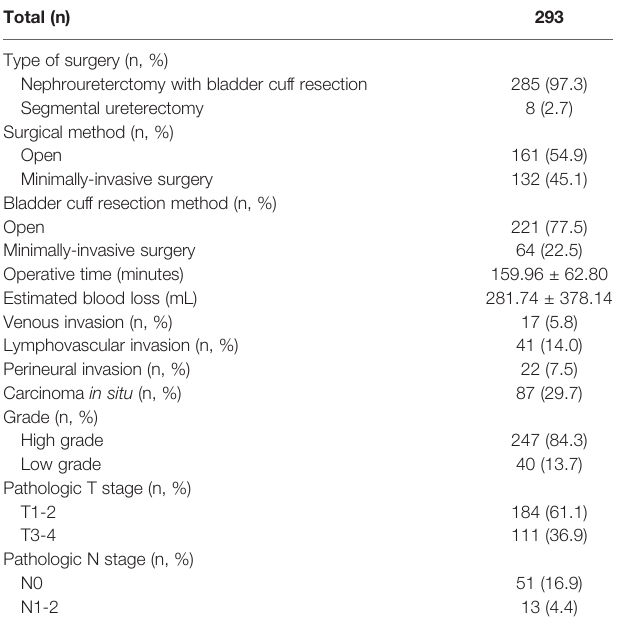
TABLE 2 | Perioperative characteristics.